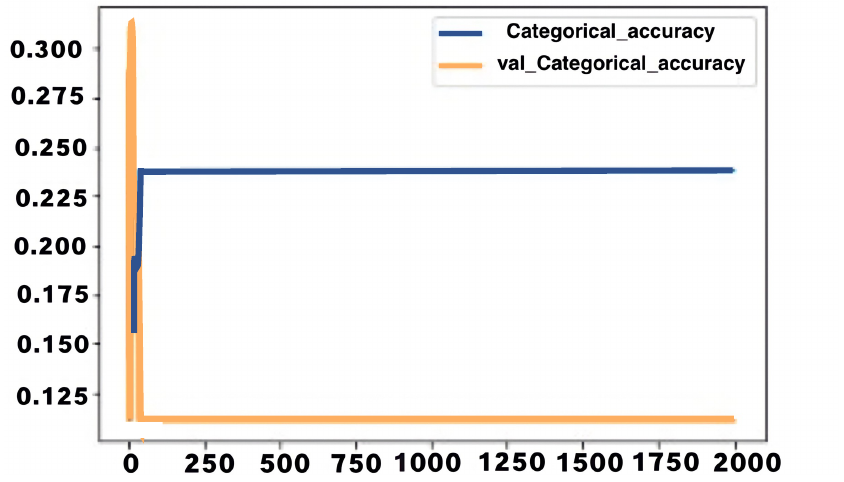
Figure 20. The second LSTM training and testing accuracy against the number of